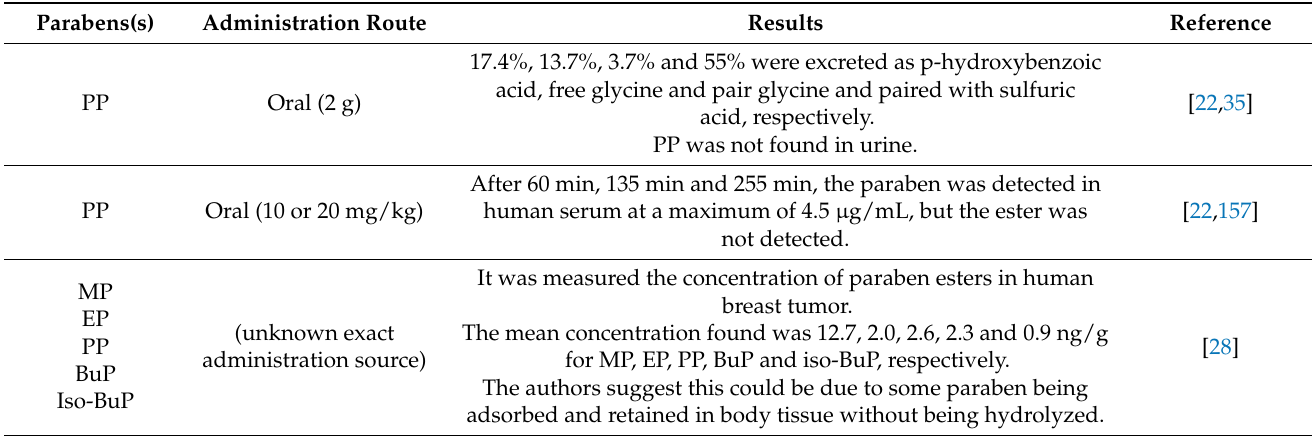
Table 6. Detection, metabolization and extraction of parabens in